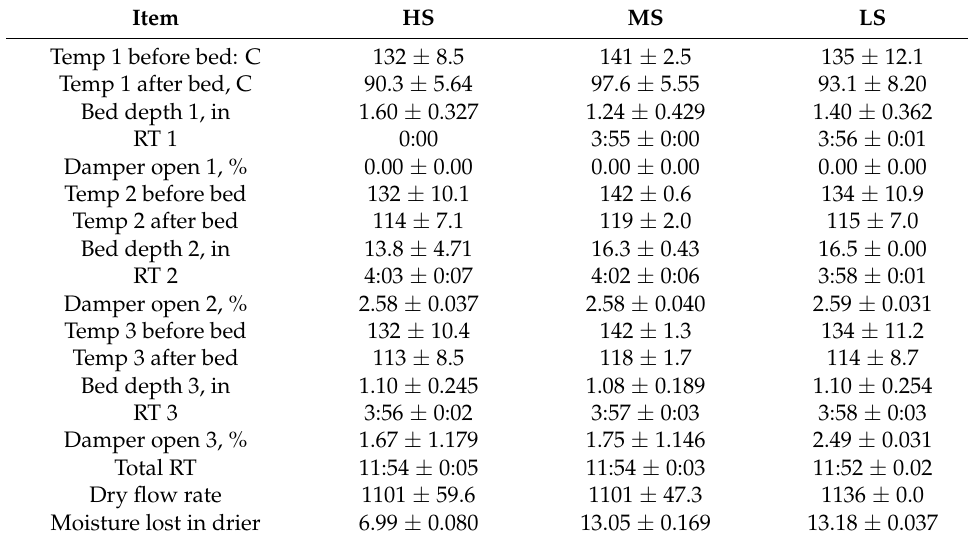
Table A1. Drier settings used during the X115 Extrusion (average ± standard